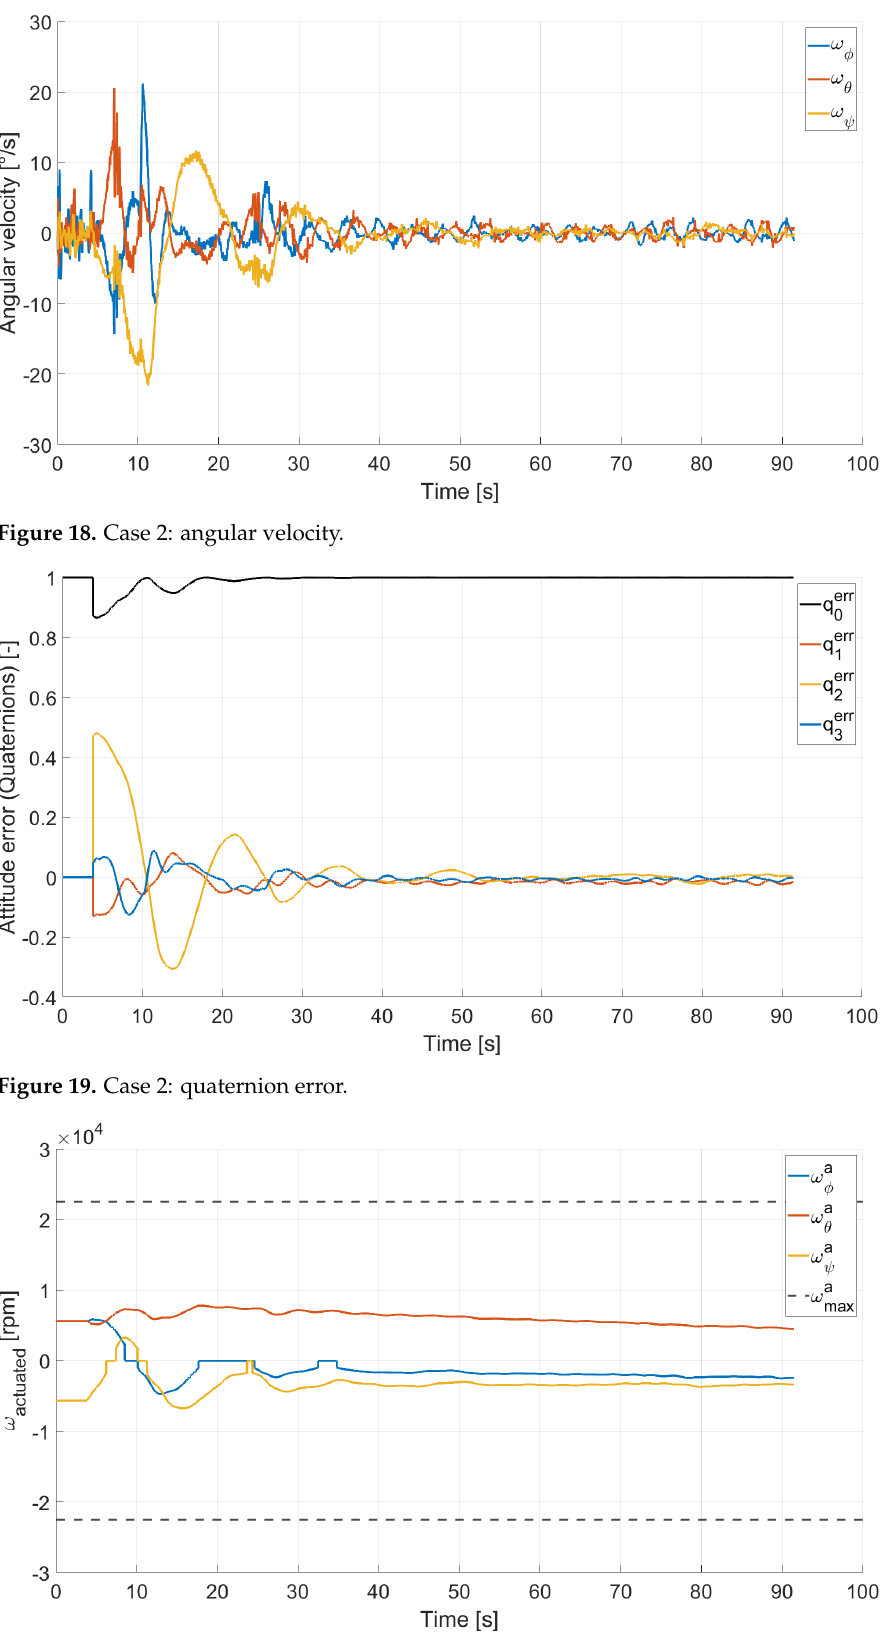
Figure 20. Case 2: RW actuated angular